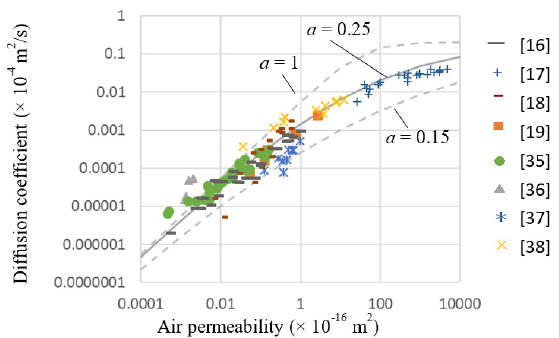
Figure 6. Relationship between the air diffusivity and permeability described by Eq.